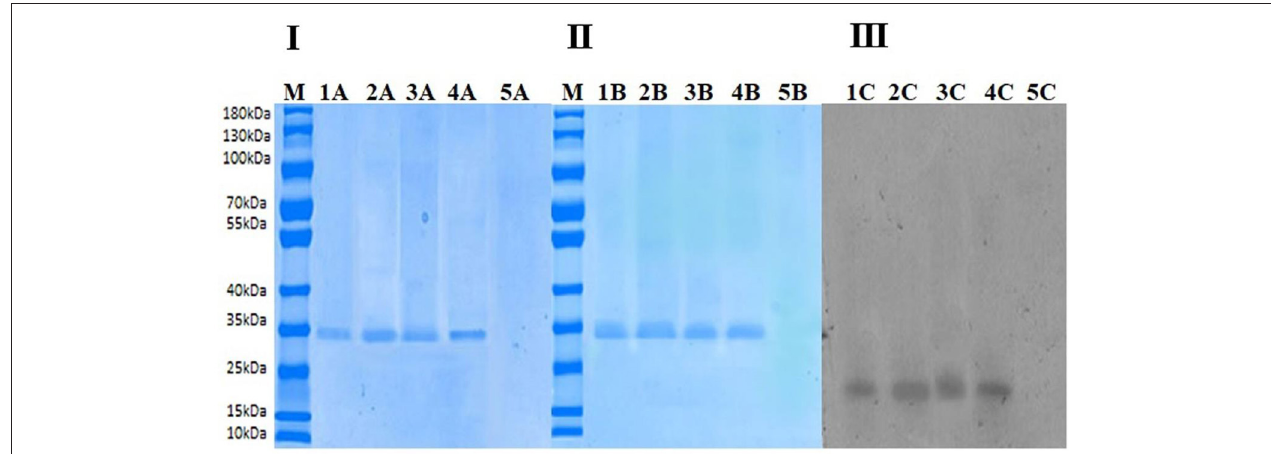
FIGURE 5 | (I) Sodium dodecyl sulfate-polyacrylamide gel electrophoresis (SDS-PAGE). In the above figure, M indicates marker, Lane 1A indicates nonthermally treated PPO. Lane 2A shows thermally treated PPO at 40 ◦ C for 10min. Lane 3A shows thermally treated PPO at 40 ◦ C for 60min. Lane 4A shows thermally treated PPO at 70 ◦ C for 10min. Lane 5A shows thermally treated PPO at 70 ◦ C for 60min. (II) Native PAGE stained with Coomassie Brilliant Blue R-250. In the above figure, M indicates marker, Lane 1B indicates nonthermally treated PPO. Lane 2B shows thermally treated PPO at 40 ◦ C for 10min. Lane 3B shows thermally treated PPO at 40 ◦ C for 60min. Lane 4Bshows thermally treated PPO at 70 ◦ C for 10min. Lane 5B shows thermally treated PPO at 70 ◦ C for 60min. (III) Native PAGE stained with catechol. In the above figure, Lane 1C indicates non-thermally treated PPO. Lane 2C shows thermally treated PPO at 40 ◦ C for 10min. Lane 3C shows thermally treated PPO at 40 ◦ C for 60min. Lane 4C shows thermally treated PPO at 70 ◦ C for 10min. Lane 5C shows thermally treated PPO at 70 ◦ C for